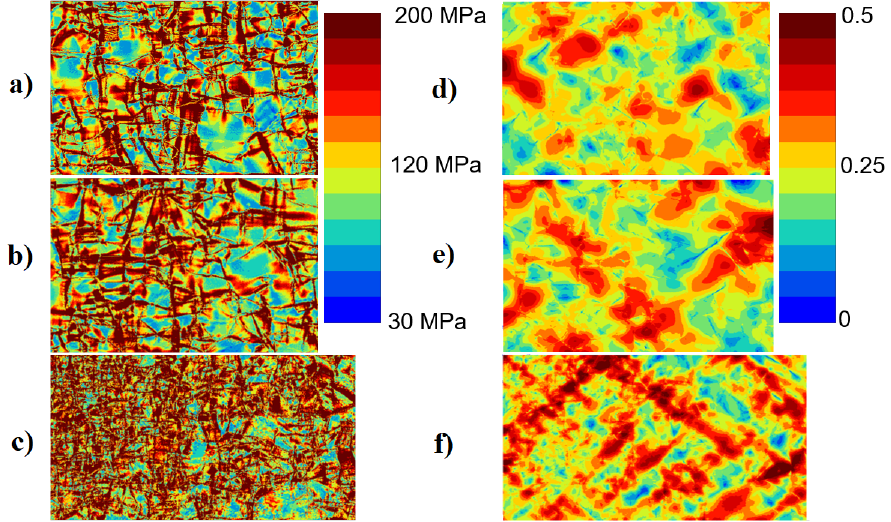
Figure 5. von Mises stress and cumulative plastic slip contours for materials A ( a , d ), B ( b , e ) and welded ( c , f ),